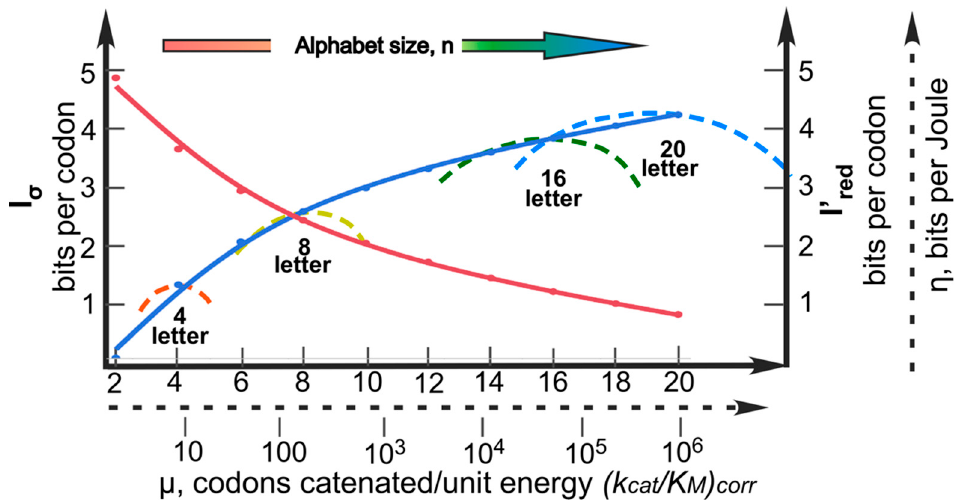
Figure 5. Representative curve (blue) for coded information content I σ (bits per codon or amino acid; left hand Y axis) versus alphabet size, n. Nominal rate of translation, μ , on log(k cat /K M ) is indicated by the dashed proxy scale. Typical curves (dashed, color spectrum) for information transferred per unit energy expended per monomer concatenated, η , (bits per Joule per monomer, arbitrary dashed scale on right hand Y-axis) for aaRS evolution through progressive stages of increasing amino alphabet size, n. Redundancy (red curve), I’ red versus n, is averaged out over the codon and amino acid alphabets.